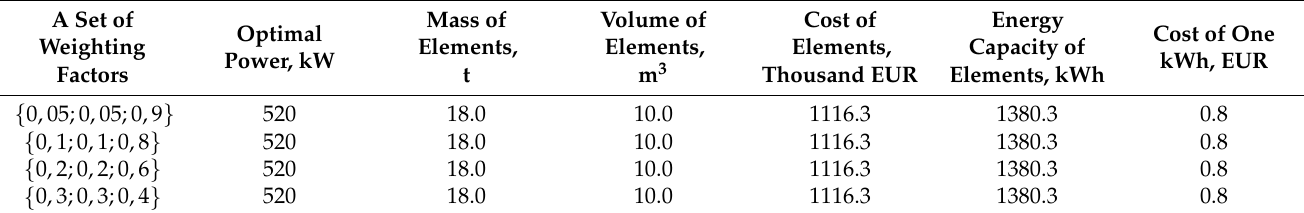
Table 9. Results of calculations of ES parameters with hybridization LFP- and LTO